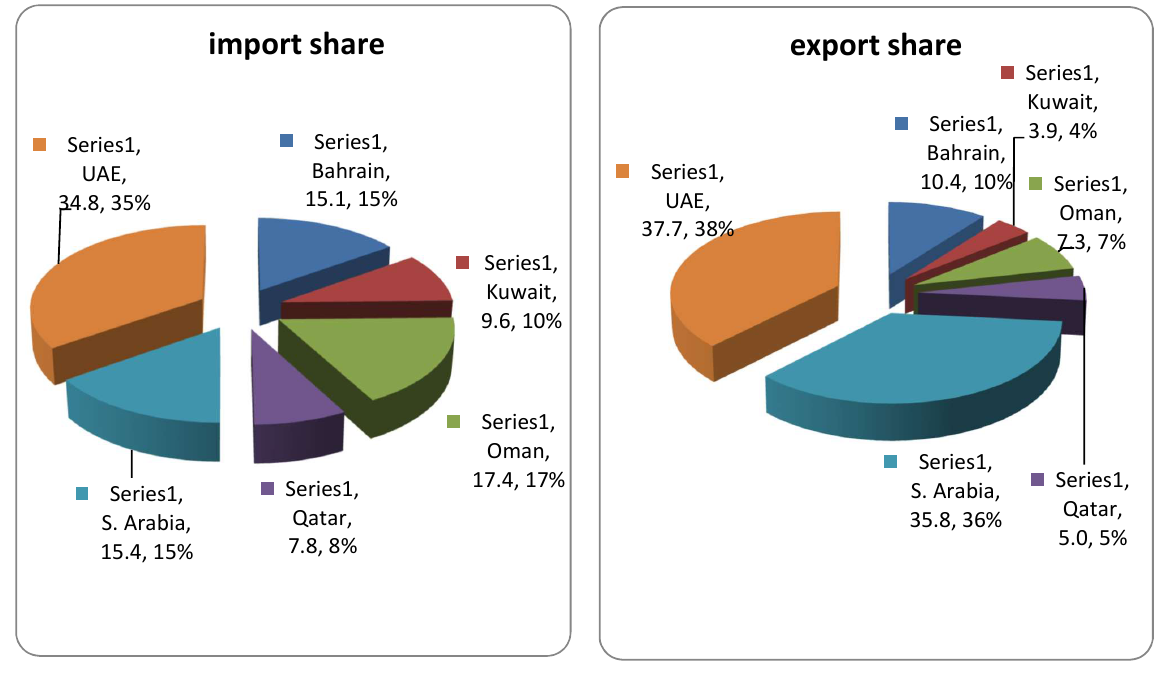
Fig. 3. Share of GCC countries of intra import average of